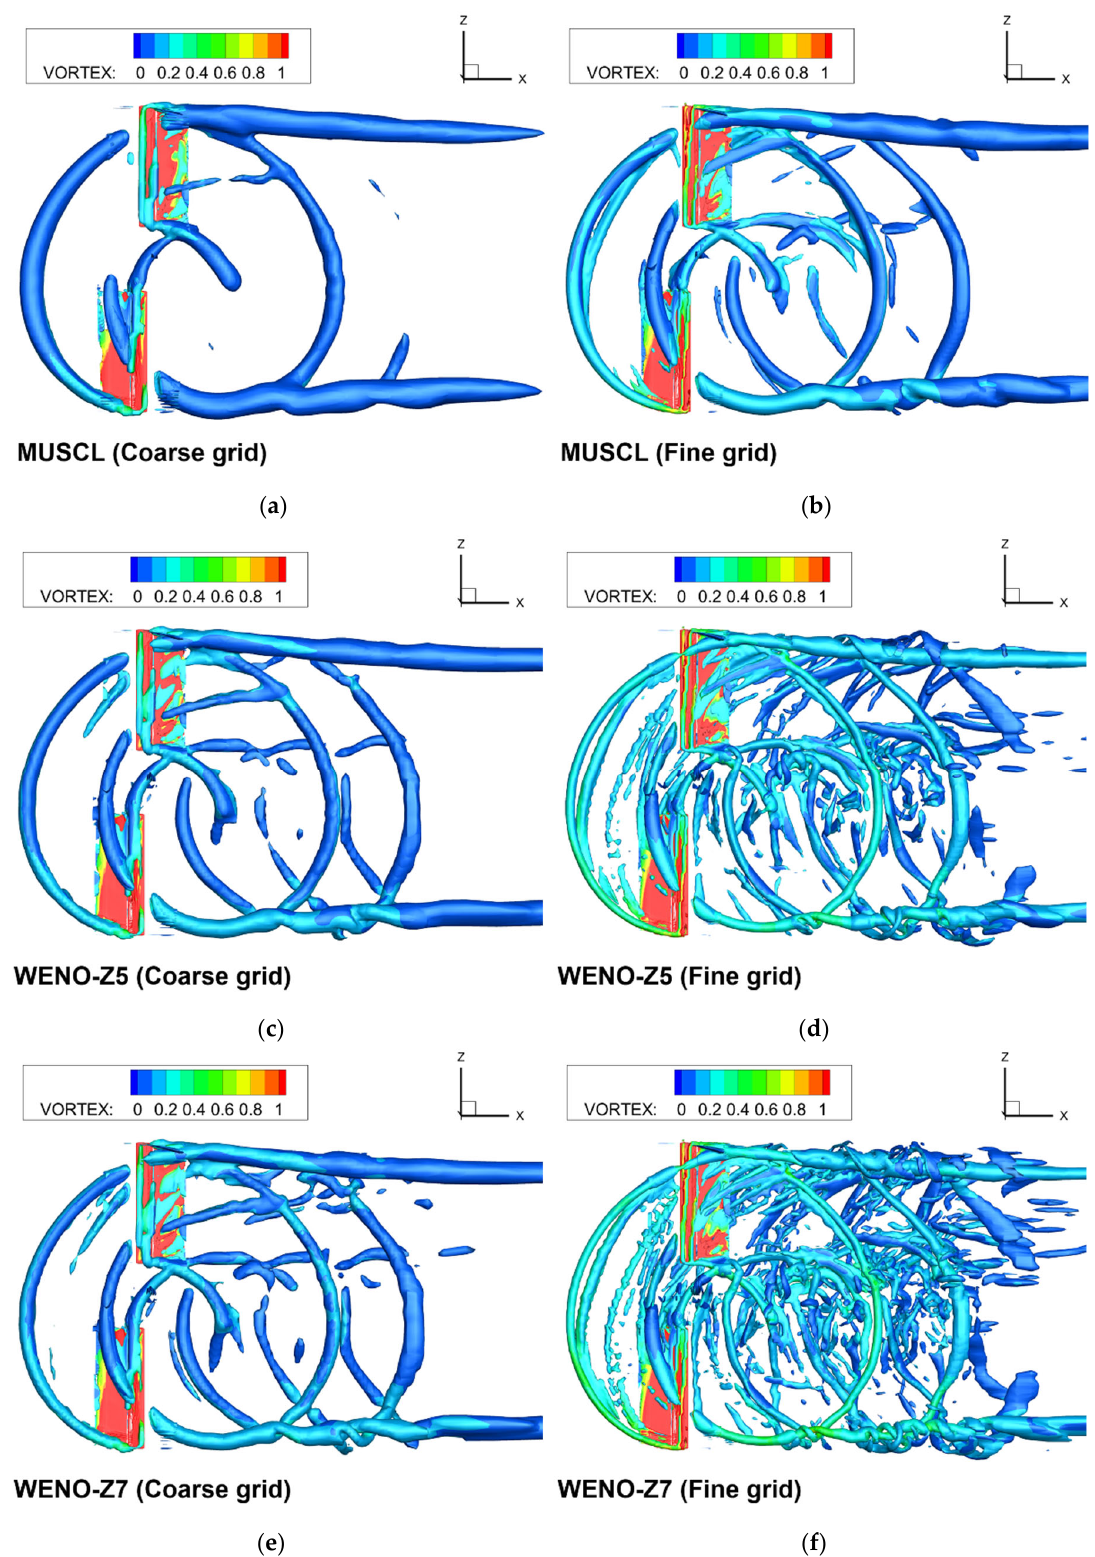
Figure 9. The iso ‐ surfaces of the Q criterion at Q = 0.001 (colored by vorticity magnitude) of the OLS rotor for the WENO ‐ Z and the MUSCL schemes for the coarse and fine grids: ( a ) MUSCL (coarse grid); ( b ) MUSCL (fine grid); ( c ) WENO ‐ Z5 (coarse grid); ( d ) WENO ‐ Z5 (fine grid); ( e ) WENO ‐ Z7 (coarse grid); ( f ) WENO ‐ Z7 (fine grid).